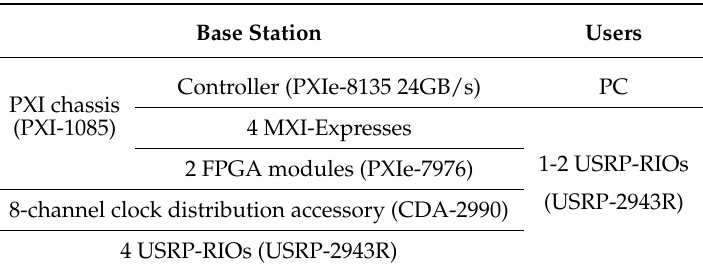
Table 1. The hardware list of Base Station (BS) and